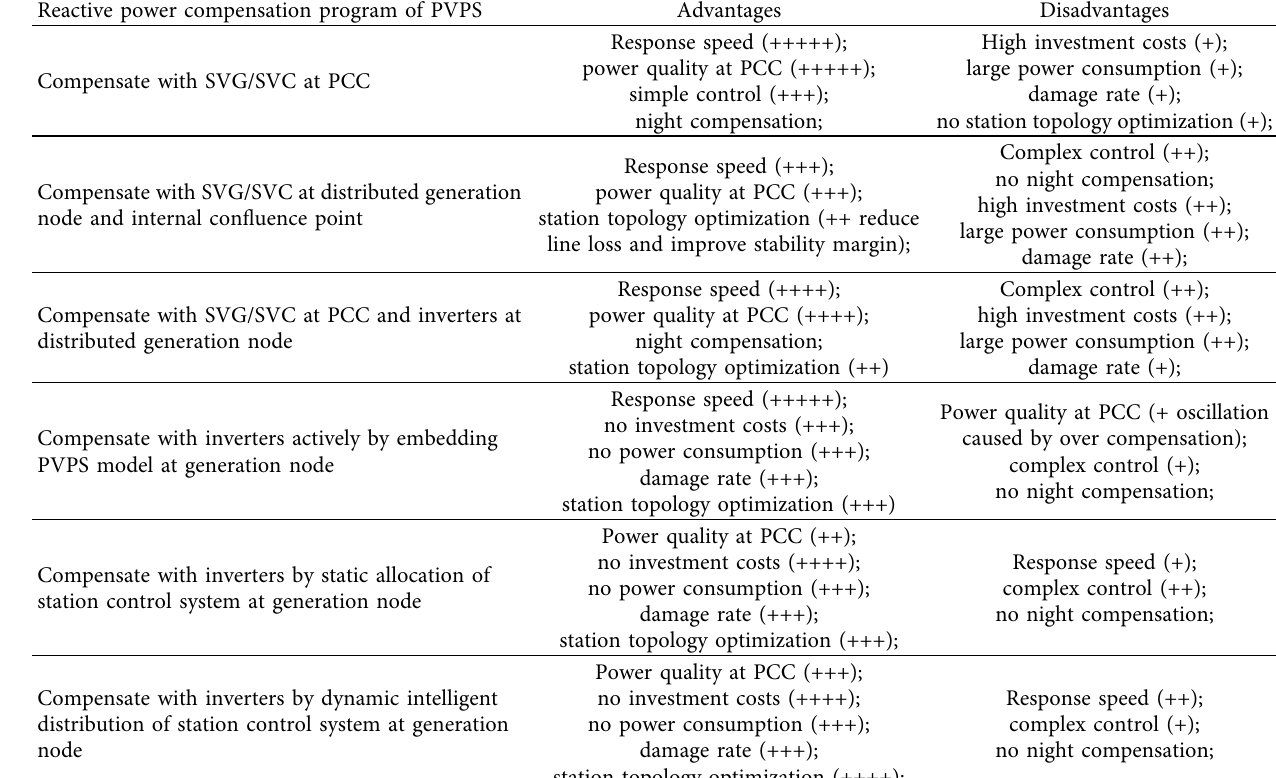
Table 1: VCC algorithm comparison